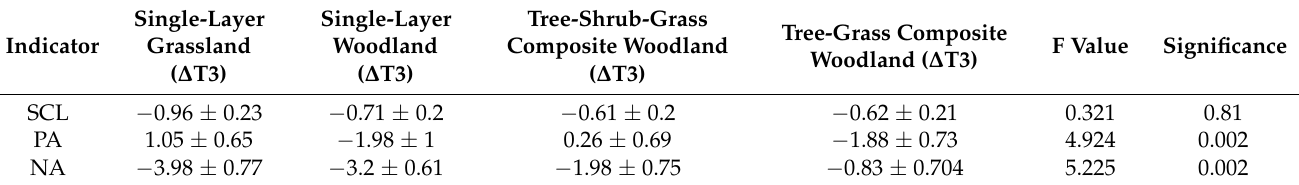
Table 2. Differences in recovery values among different types of plant